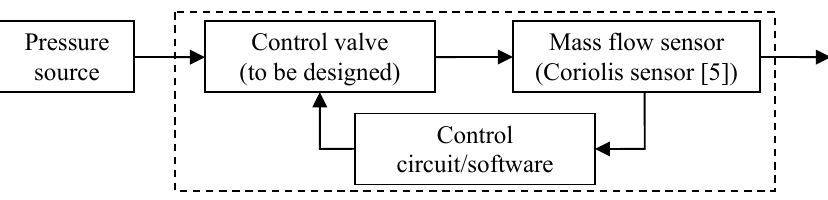
Figure 1. Functional model of a typical mass flow controller (dashed box), consisting of a control valve, flow sensor and control